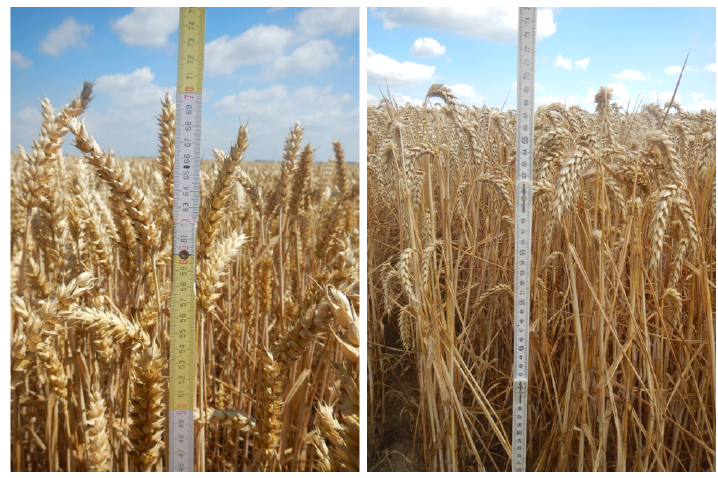
Figure 10. Wheat field “Hey” at 13th of July 2017 ( left ) and wheat field “G” at 16th of July 2018 ( right ).